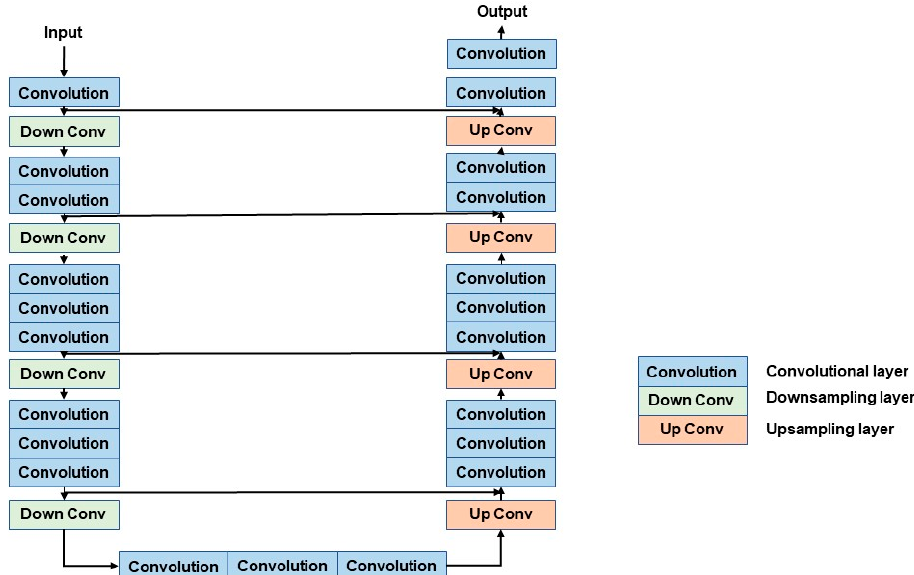
Figure 3. The structure of the V-Net model. The left encoder includes four down-sampling modules, the right decoder includes four up-sampling modules.